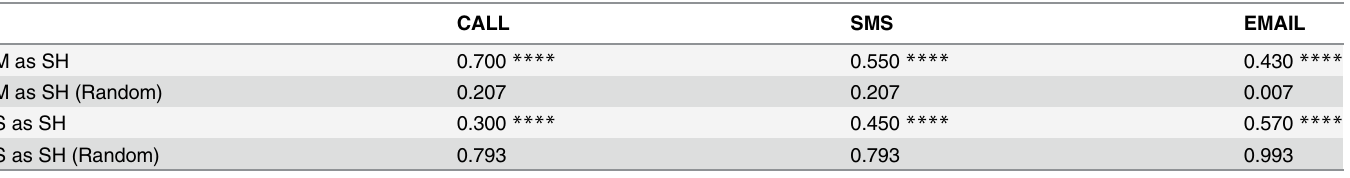
Table 1. Structural Holes vs. Social Status. The probability that staffs in companies are spanned as structural holes (SH) extracted from communication network structures. M: Managers; S: